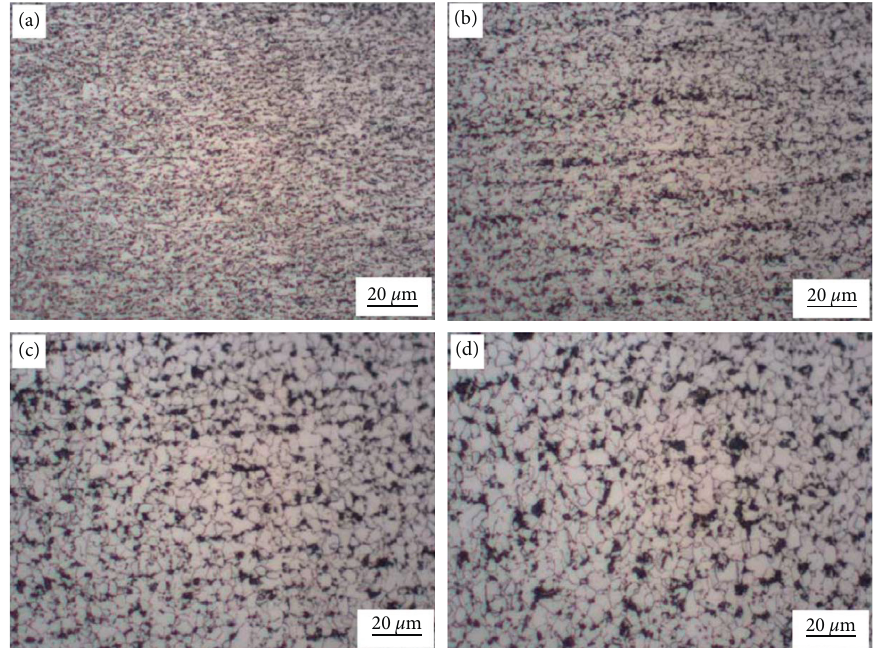
Figure 2: Optical microstructure of the weld joint: (a) base metal, (b) heat-affected zone (HAZ) close to the base metal, (c) HAZ close to the weld junction, and (d) weld junction.